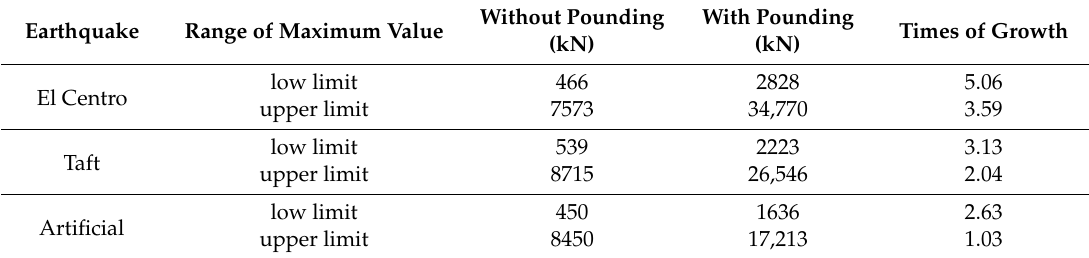
Table 2. Maximum values of story shear-force for model A.